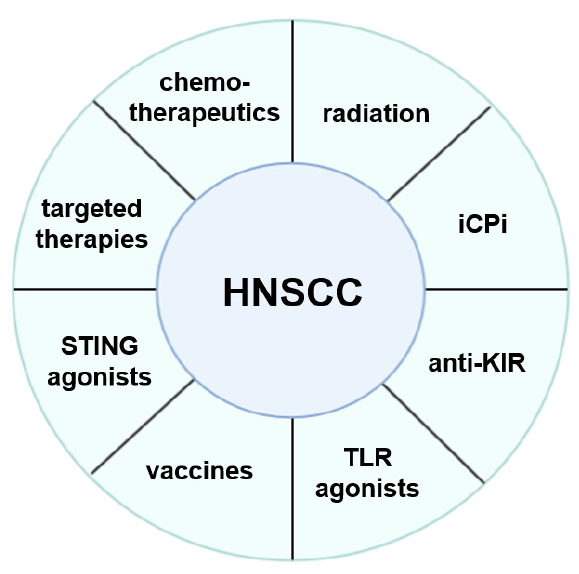
Figure 1. Di ff erent therapeutic options for the treatment of Figure 1. Different therapeutic options for the treatment of HNSCC.